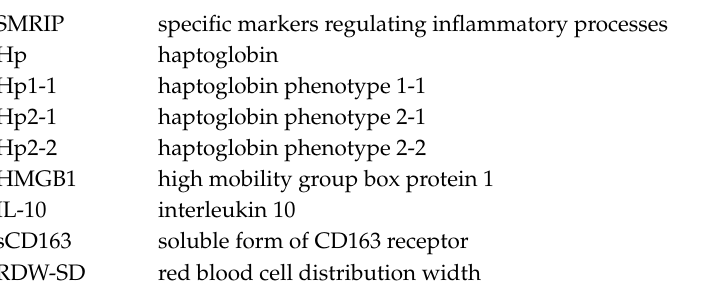
Table S1: Frequency analysis of quantitative variables. Classification due to haptoglobin type. Table S2: Frequency analysis of quantitative variables. Parametric analysis with the t-student test Classification due to cardiovascular